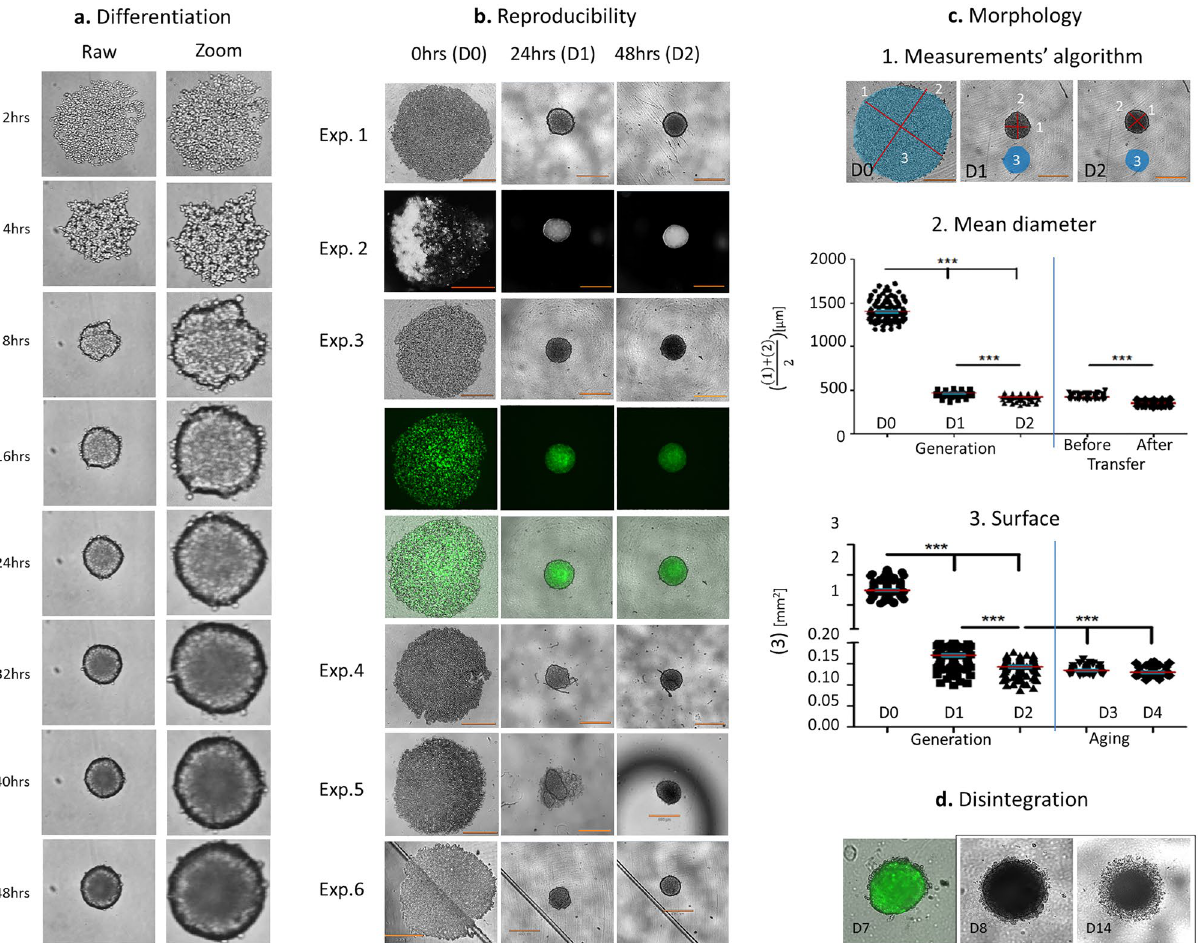
Figure 1. Generation of Sw71 spheroids as a model of early human placenta. ( a ) Differentiation of spheroid from Sw71 cells visualized at different time-points: 2–8 h—aggregation; 8–24 h—compaction, 24–48 h—stable spheroid. Left column—formation of a single differentiated spheroid with intact border, right column— additional digital zoom to show the formation of intact periphery. ( b ) Reproducibility (exp. 1–3) and some obstacles (exp. 4–6) during differentiation of the models exemplified by representative Sw71 spheroids captured at D0, D1 and D2 (6 independent experiments): exp. 1—fine spheroid, brightfield view; exp. 2—fine spheroid, phase contrast view; exp. 3—fine Sw71-GFP spheroid, trans, fluorescent and overlaid view; exp. 4—mechanical non-organic contamination; exp. 5—nonoptimal humidity; exp. 6—plate defects. ( c ) Sw71 spheroids’ morphological characteristics: 1. Measurements; 2. Mean diameter values of Sw71 spheroids (n = 126) at D0, D1 and D2, and before and after their transfer; 3. Surface measured for the same spheroids. ( d ) Sw71 spheroids’ disintegration during long term culture without additional feeding presented by two representative spheroids. Left—Sw71-GFP spheroid on D7 in overlayed view. Right—Sw71 spheroid, pictured on D8 and D14. Imaging: ( a ) time-lapse live cells imaging system OMNI (CytoSmart Technology, The Netherlands), magnification 10× (+ manual digital zoom), pictures taken every 2 h, but only selected images were included. ( b , c , d ) ECHO Revolve microscope (RVL-100-M, Echo, San Diego, CA, USA), magnification 4×. Bars ( b , c ) = 530 µm. Statistics was processed with GraphPad Prism v.5.0